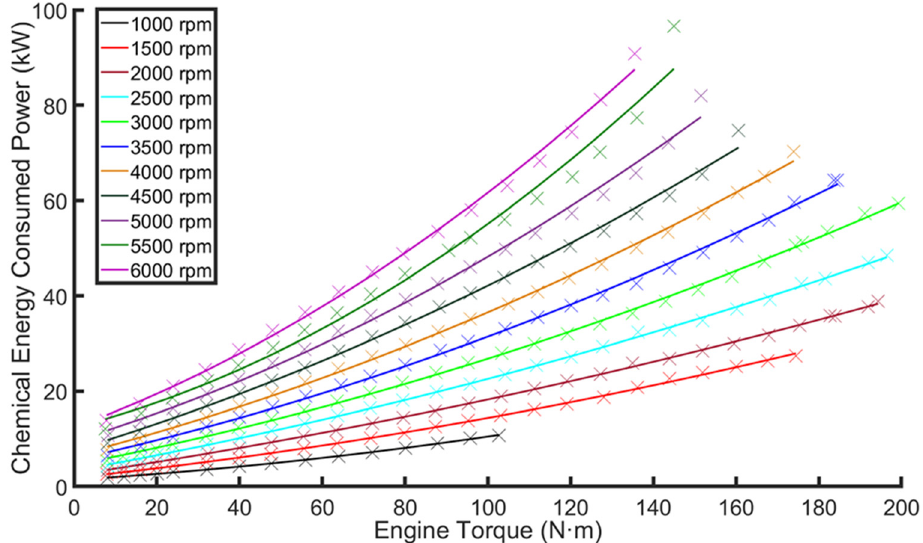
Figure 2. Fitting results of the chemical energy consumed power.